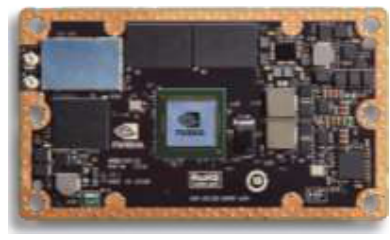
Fig. 2. Nvidia Jetson TX2